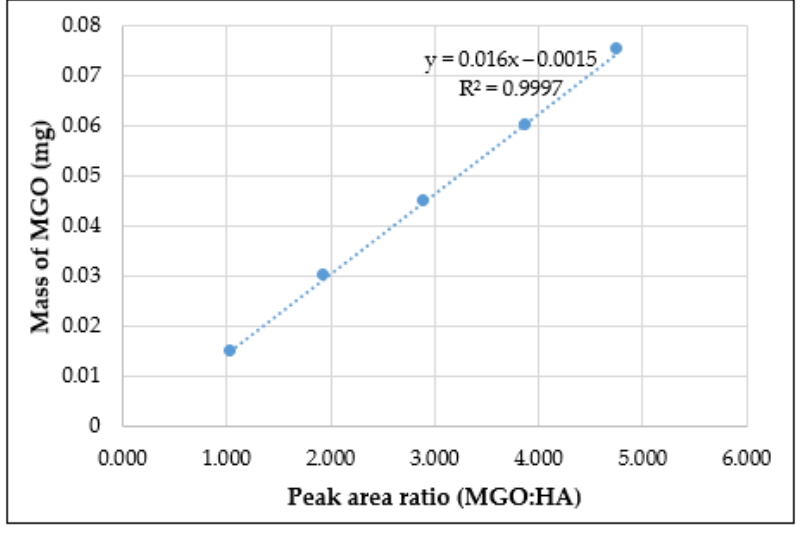
Figure 2. MGO calibration curve.